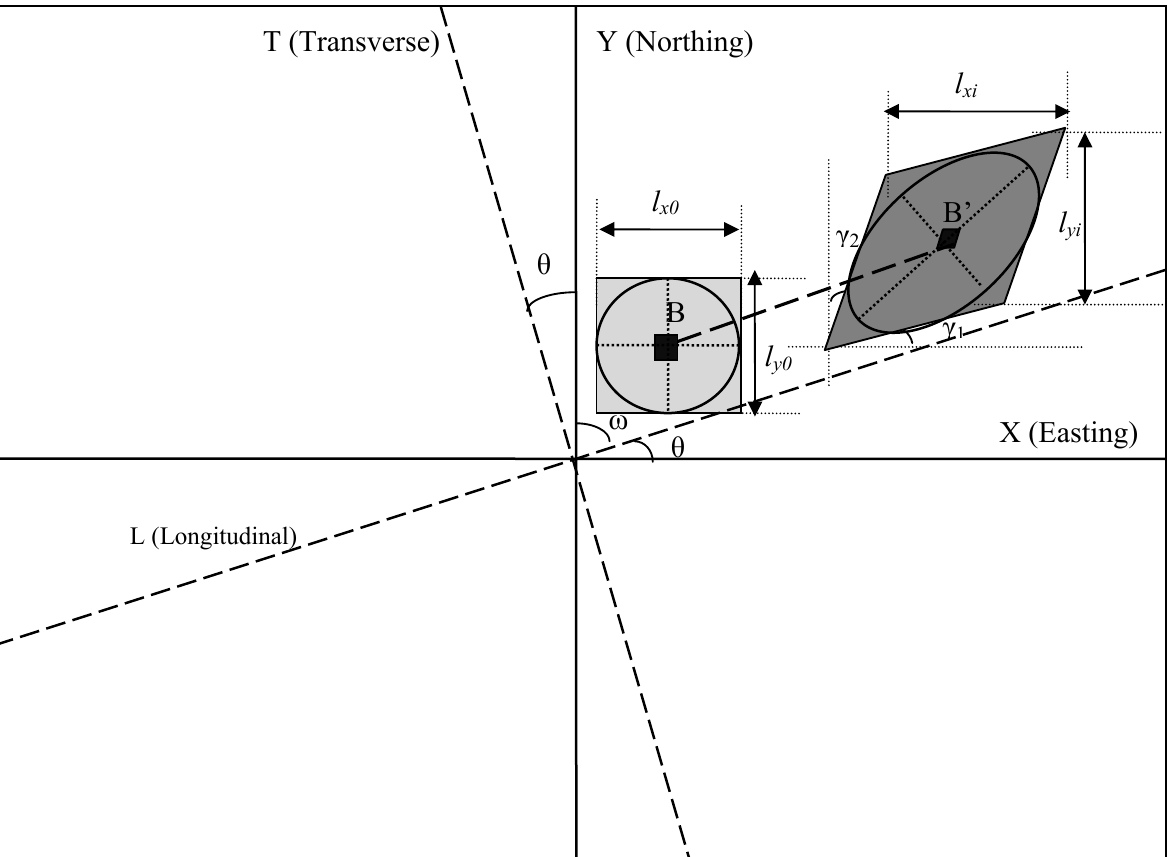
Figure 1. Deformation of a template and transformation of its parameters from easting-northing to longitudinal-transverse